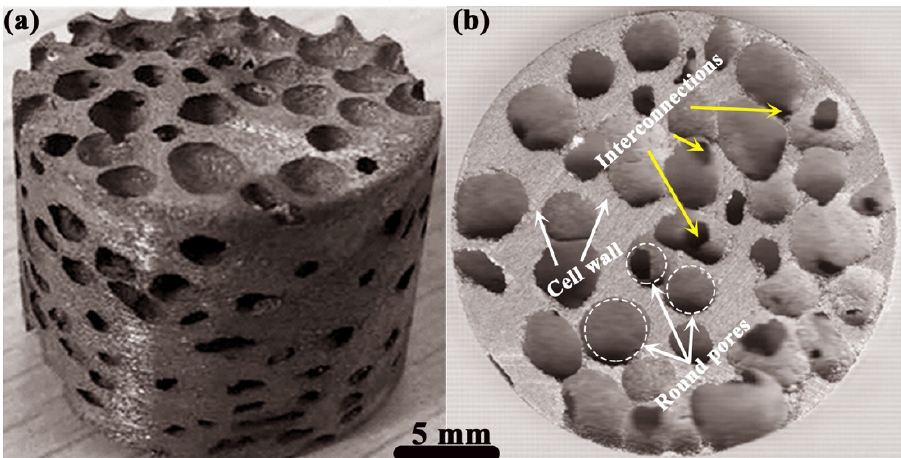
Figure 3. Image of the porous Mg alloy foam with porosity of 60.2% after sintering ( a ) and its corresponding cross-section image ( b ).